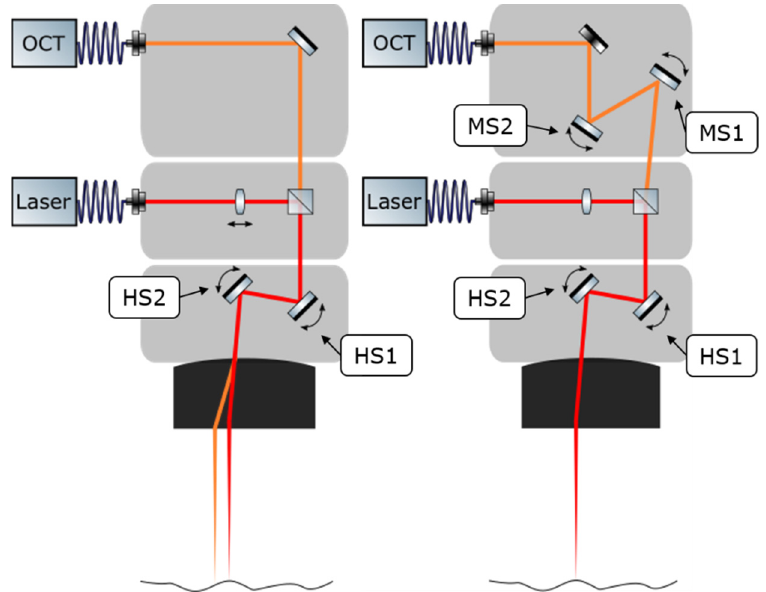
Figure 7. System comparison with and without beam manipulation. Left: the coupling of both beam paths without the adjustment of the measuring beam and the resulting lateral offset on the processing plane; right: an additional pair of galvanometer mirrors (MS1 and MS2).